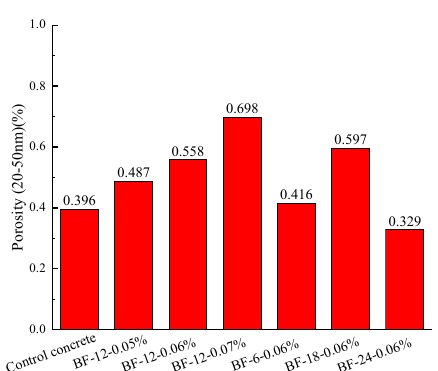
Figure 14. Porosity of BFRCs with pore size ranges from 20 to 50 nm.